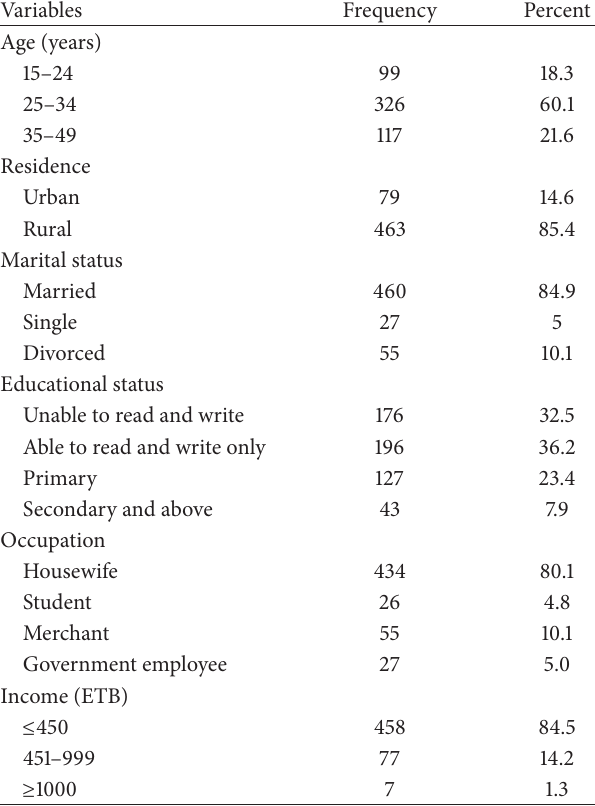
Table 2: Reproductive health related characteristics and